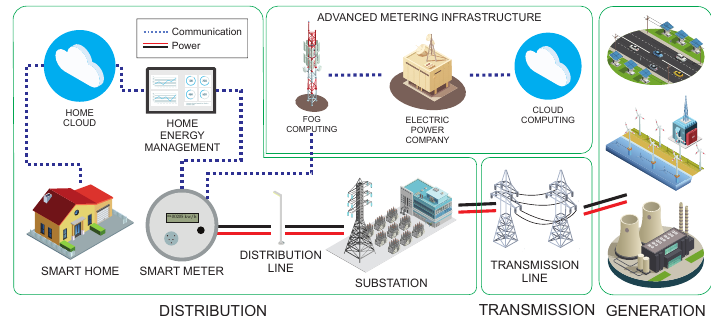
Figure 2. Advanced Metering Infrastructure